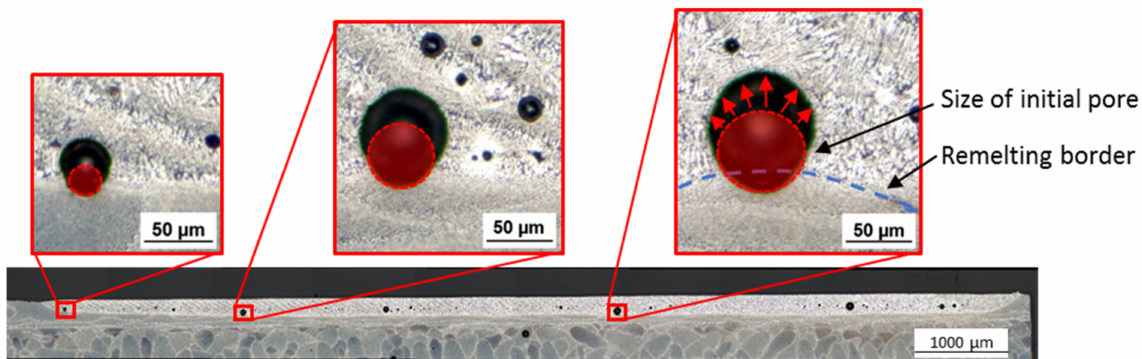
Figure 18. Expansion of pores from the L-PBF process at the border of the remelting zone. Additionally, some surface open pores can be detected. These pores are deep and exhibit partly a wavy wall of the pores (see Figure 19b). At the bottom of some pores spherical particles can be detected which may result from an initial defect in the part by lack of fusion within the L-PBF process (see Figure